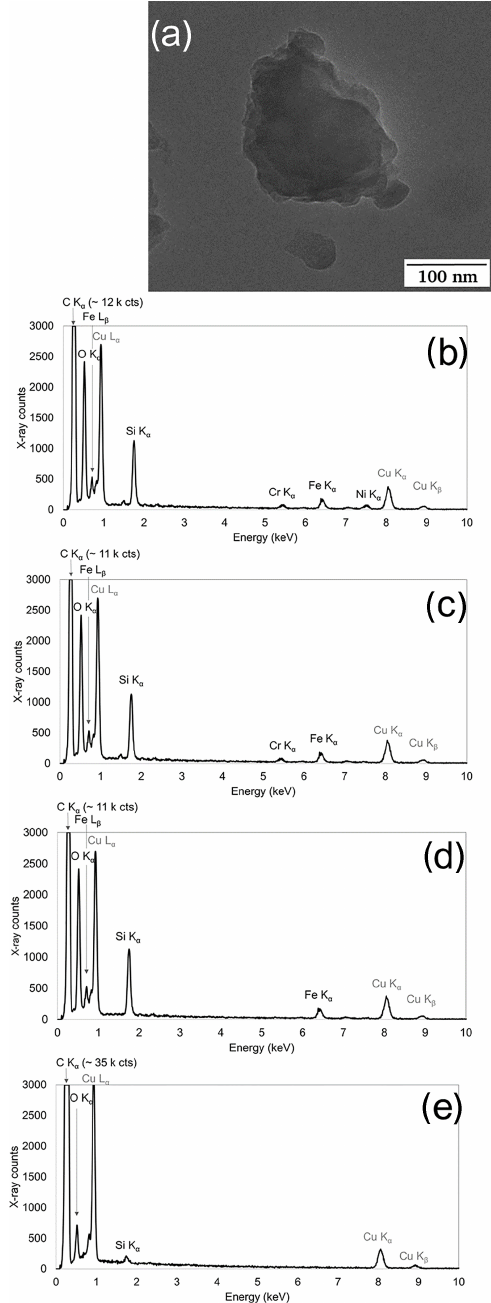
Figure 2. TEM bright-field image (a) of a typical refractory car- bonaceous particle from sample H (19.1km altitude). The image is representative of all refractory carbonaceous particles. The mor- phology is not depending on chemical composition, size, morphol- ogy or nanostructure. Energy-dispersive X-ray spectra of (a) a typ- ical refractory carbonaceous particle with Fe, Cr and Ni, (c) Fe and Cr, (d) Fe and (e) without any other minor constitute. The particle predominantly consists of C and O. Minor amounts of Si are always present and may partly be an artifact of the substrate. Cu is an arti- fact from the TEM grid. K α and K β as well as L α and L β denote different X-ray peaks emitted from the same